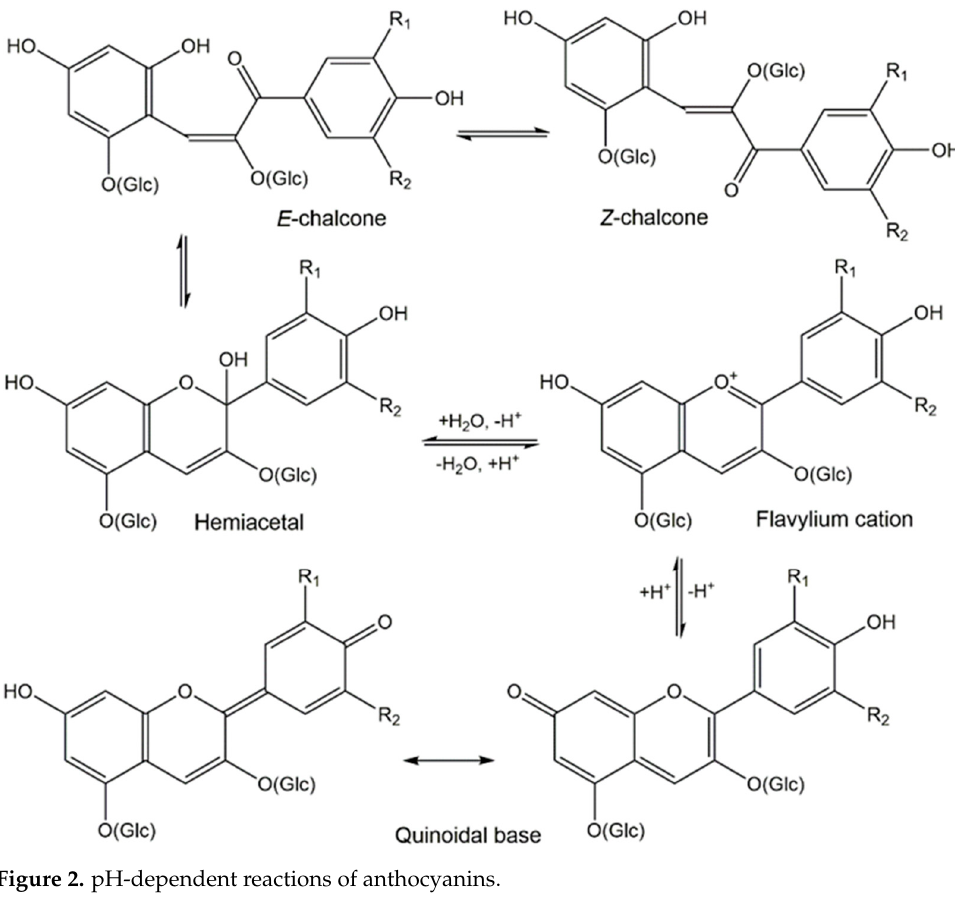
Figure 2. pH-dependent reactions of anthocyanins.